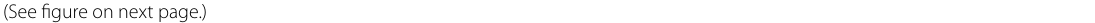
(See figure on next Fig. 3 Inverted 3-D resistivity model showing the C-1 and C-2 anomalies. a Horizontal slices at depths of 0.1, 3, and 12 km (left) and west–east vertical cross sections at X 7, 1, and – 5 km (right). Green diamonds and inverted triangles mark the MT sites. The purple polygons on the left = panels and the thick purple lines at the top of the right-hand panels show the extent of the outcrop of the Shirikomadake serpentinite complex. b 3-D view of the region of low resistivity (< 10 Ω m) viewed from the northwest. The dashed line marks the upper limit of the zone in which we replaced resistivity values in the sensitivity tests for the C-2 anomaly